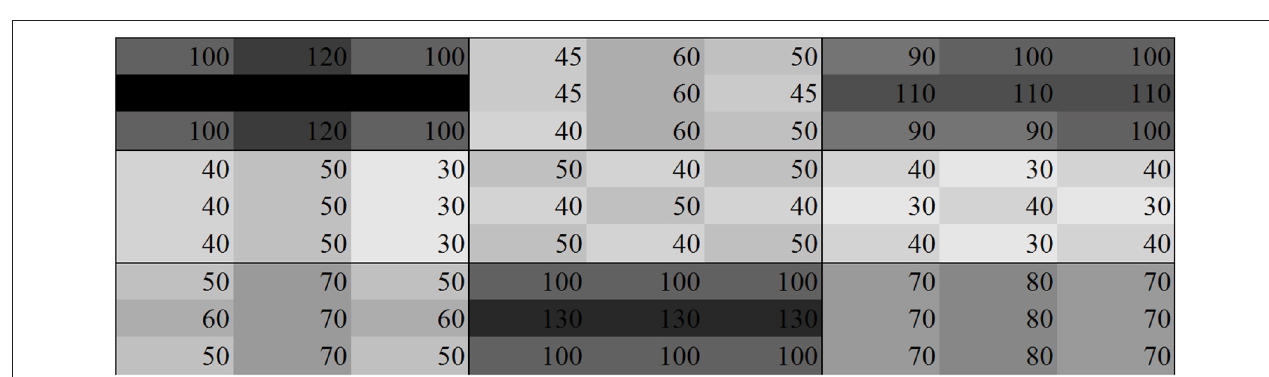
FIGURE 8 | Pareto Optimal front. Point A is one where cost installation is less emphasized, compared to Point B.